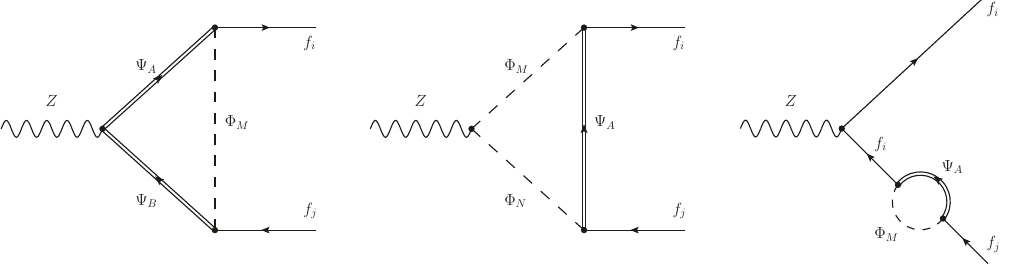
Figure 4 . Feynman diagrams modifying the Z (cid:22) f i f j vertex with f i = s; b; (cid:22)